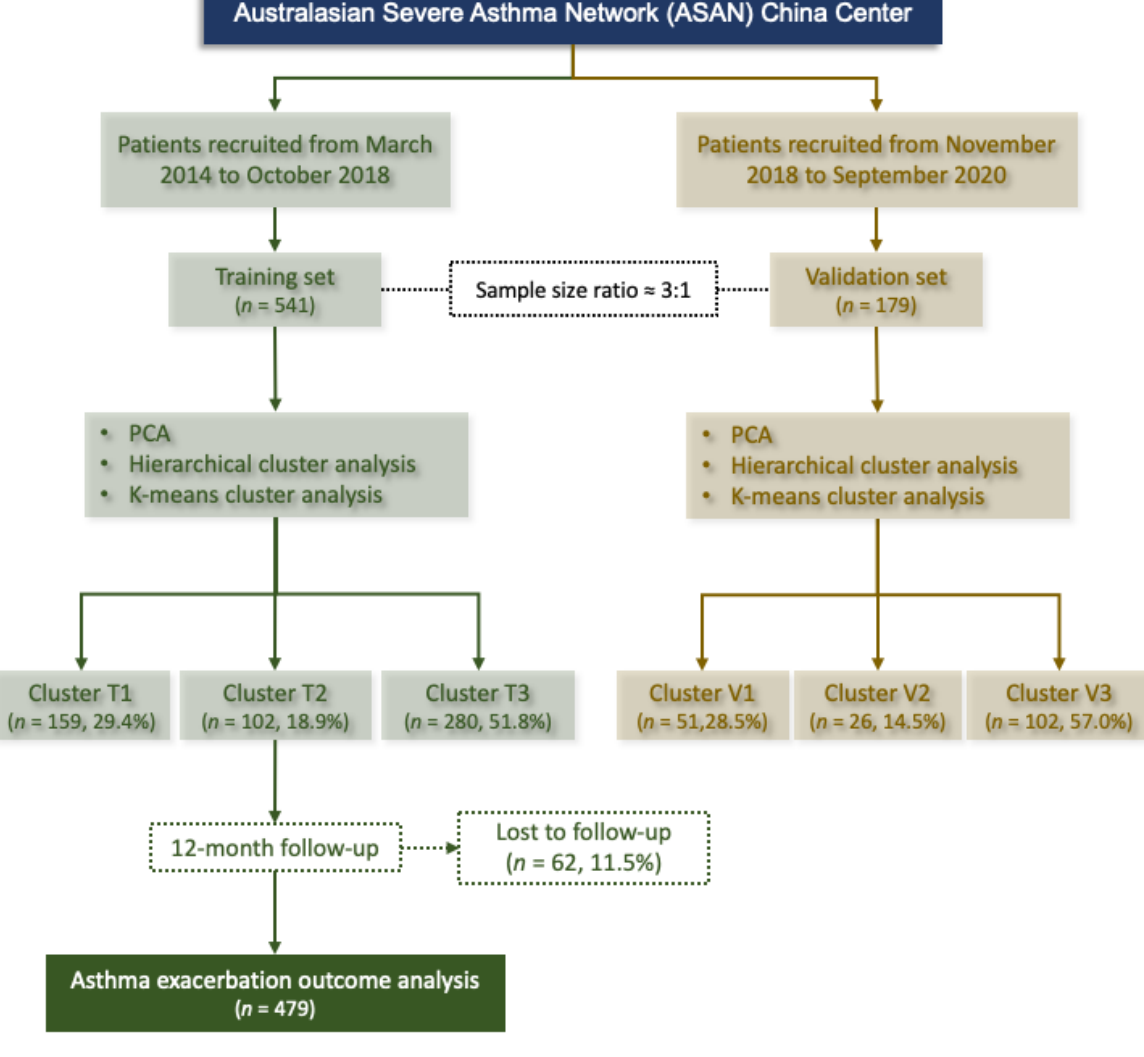
Figure 1. Flowchart for patient inclusion in the training and validation set. Cluster T, clusters identified in the training set; Cluster V, clusters identified in the validation set; PCA, principal component analysis.